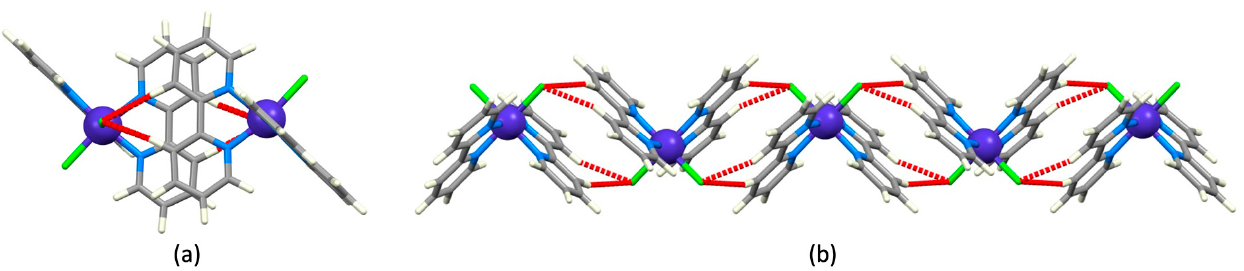
Figure 7. Packing interactions in cis- [Co(bpy) 2 Cl 2 ] (CSD refcode NAPBIT [39]): ( a ) centrosymmetric π -stacking interaction between bpy ligands with supporting H3...Cl and H3 ′ ...Cl contacts (in red), and ( b ) assembly of a 1D-chain.